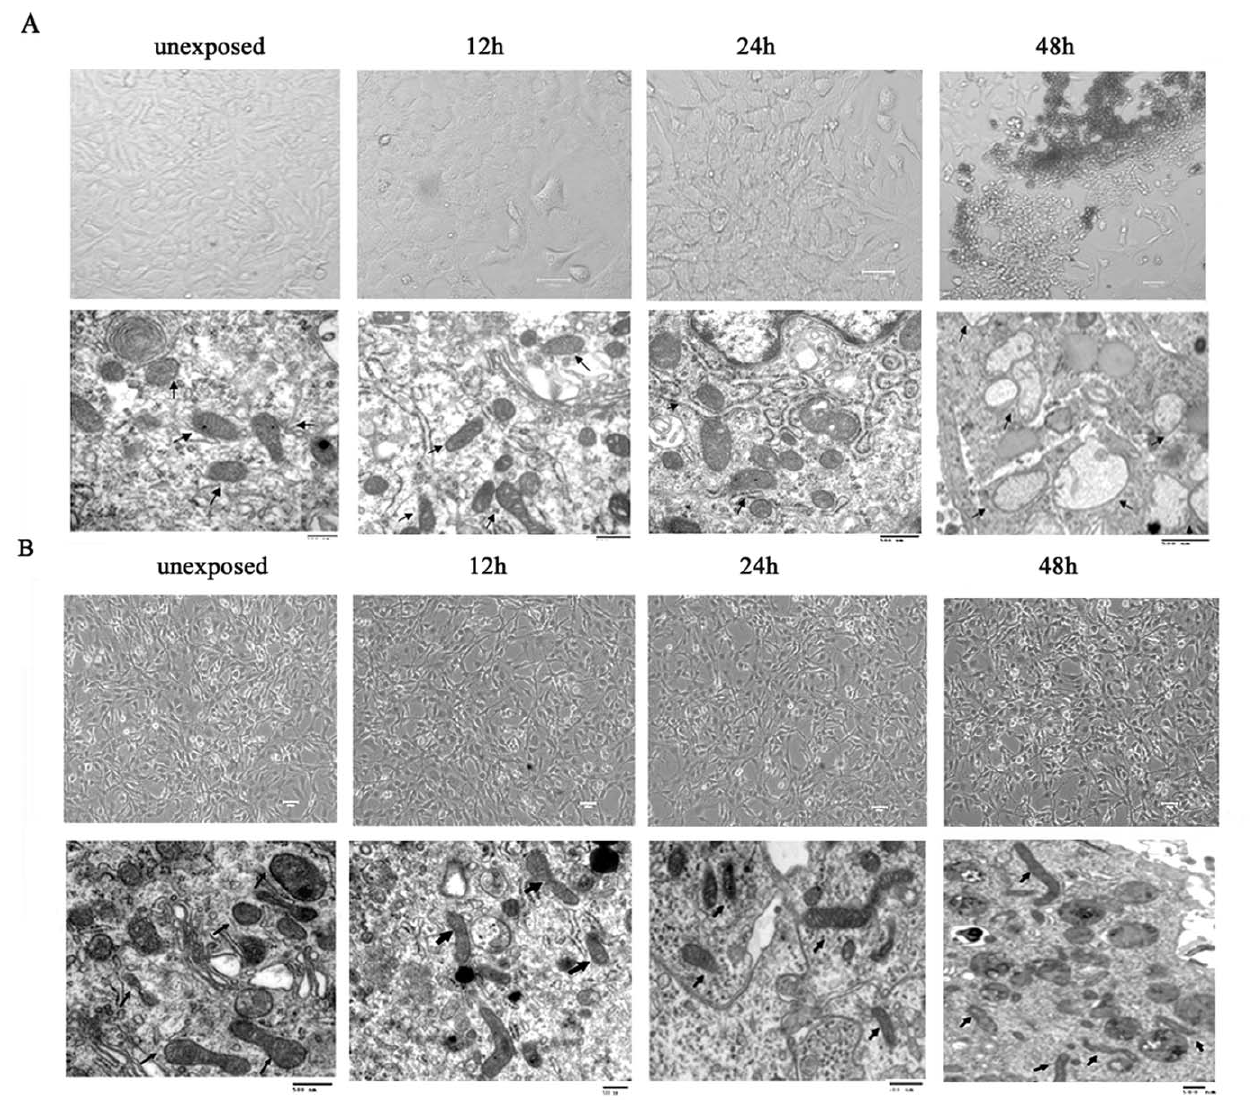
Figure 2. Effect of RF emissions on the morphology and ultra-structure of glial cells. (A) The morphology and ultra-structure of astrocytes were recorded after exposure for 12 h, 24 h, or 48 h. There were no significant differences between control and 12, 24 exposured groups. However, after 48 h of exposure, i.e., part of the astrocytes became shorter and thicker, with some shedding and structural damages in mitochondria as observed under TEM (arrow directed the mitochondria) (B) No significant differences in morphology and ultra-structure of C6 cells were noted among different experimental groups. Scale bar, 100 u m.